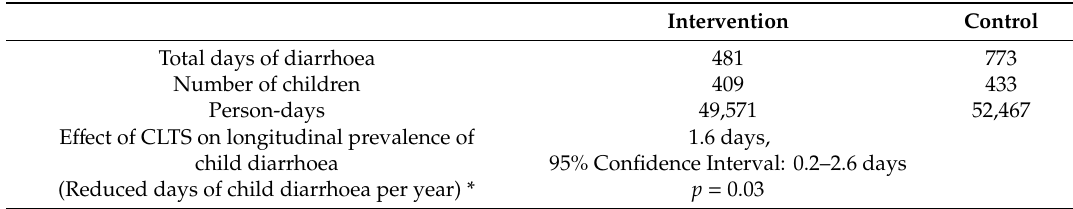
Table 1. E ff ect of a CLTS intervention on the longitudinal prevalence of child